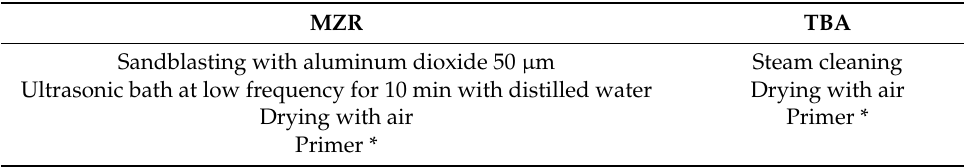
Table 3. Bonding